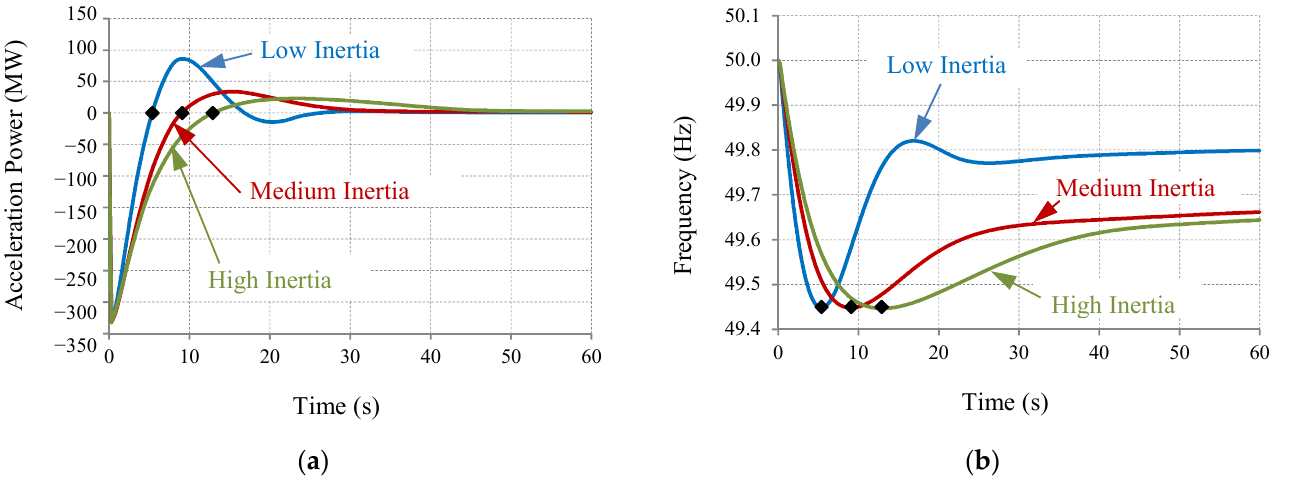
Figure 3. ( a ) Acceleration power; ( b ) frequency; in the Israeli power system after 350 MW generation trip, different inertia conditions.